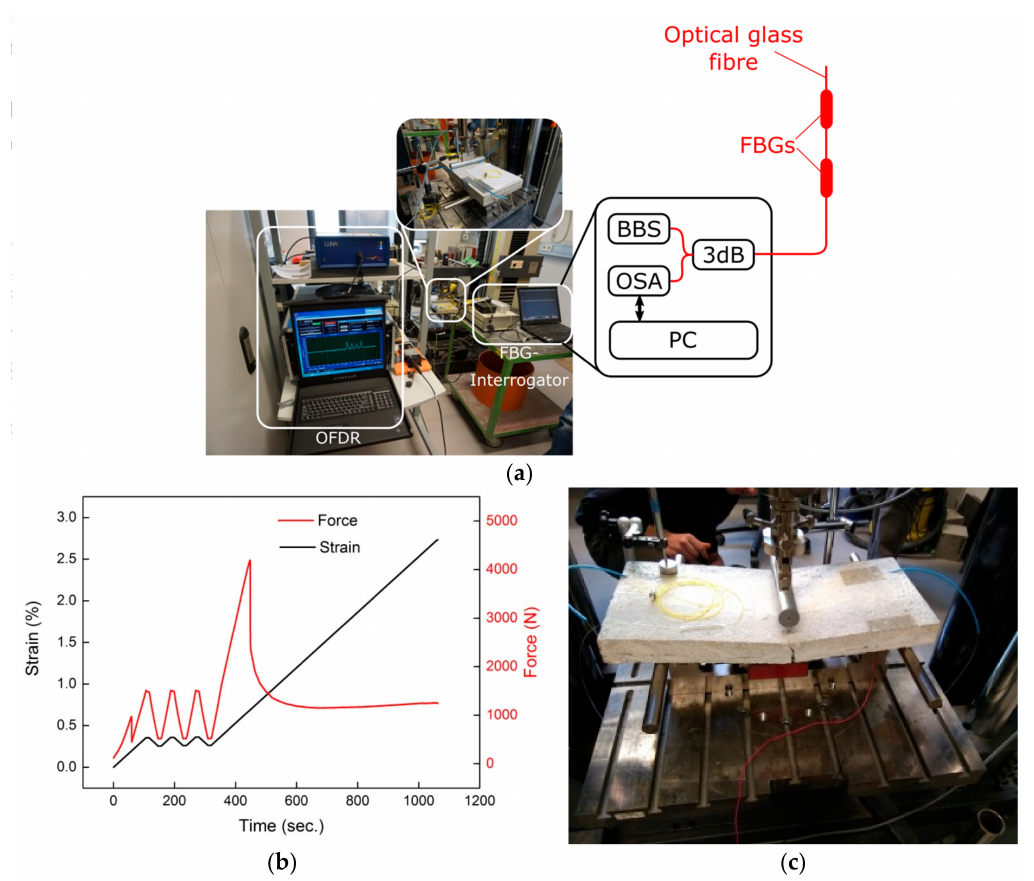
Figure 4. Experimental set-up to evaluate FCSs under practical conditions; ( a ) Concrete block containing FCS connected to the OFDR interrogator and FBG spectrometer; ( b ) Example of strain and force applied to a concrete block under test; ( c ) Concrete block with embedded FCS at the point of